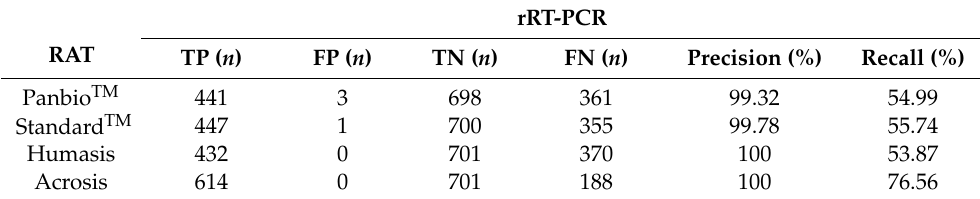
Table 1. Comparison of the diagnosis performance of the RAT kits.